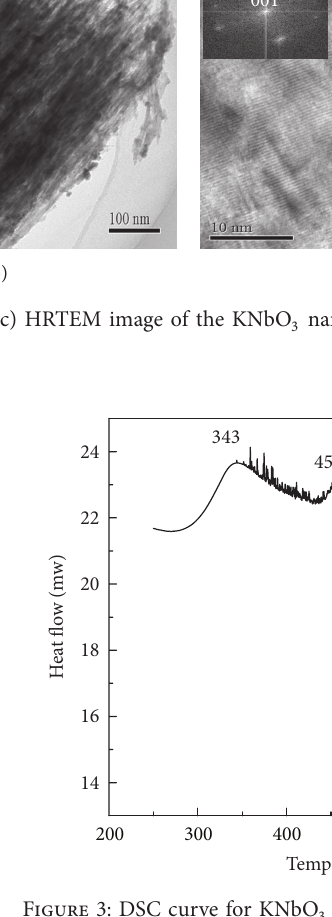
Figure 3: DSC curve for KNbO 3 nanowires recorded at the tem- perature range from 250 to 700